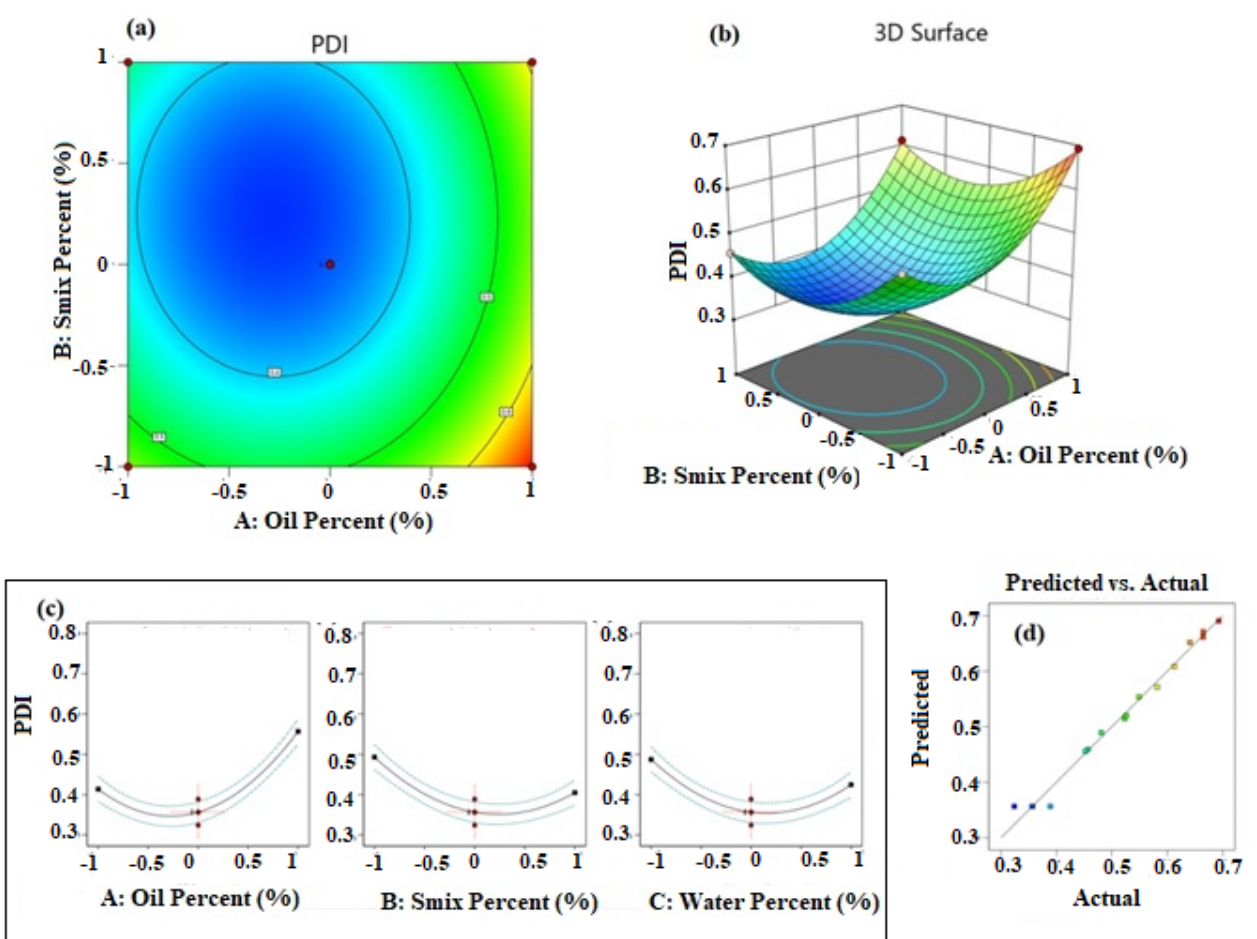
Figure 2. Results of analysis of data of PDI; ( a ) contour plot, ( b ) response surface plot, ( c ) individual factor effects, and ( d ) predicted versus actual plot.